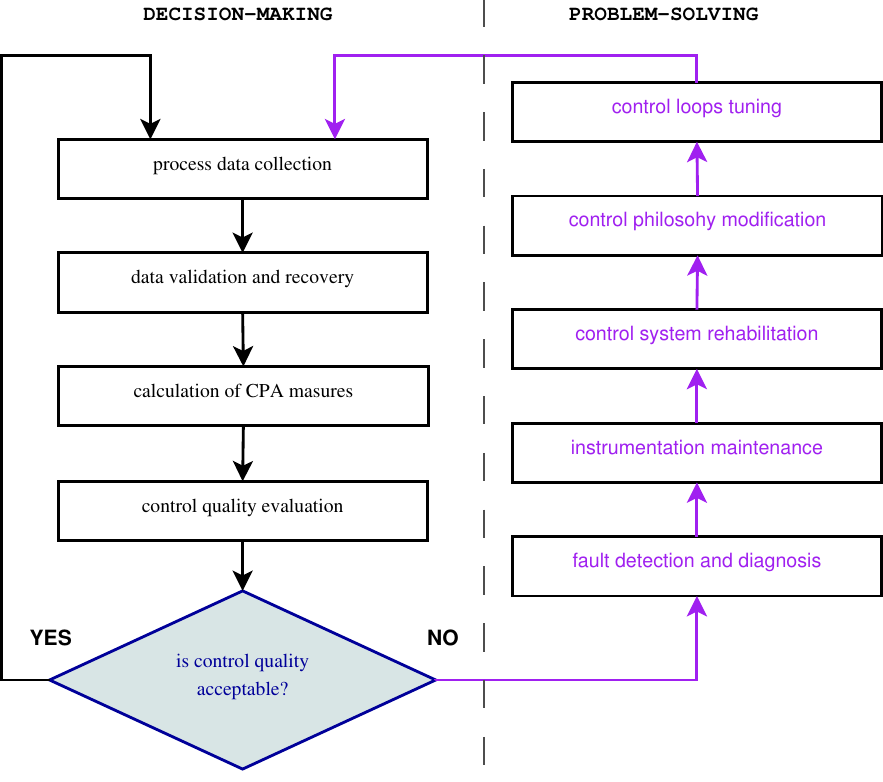
Figure 3. CPA industrial utilization